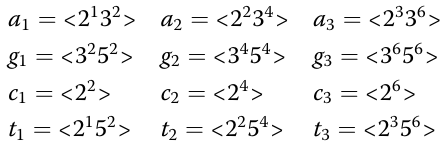
Colorizing DNA codons More interestingly, our C method can be har- 235 nessed to colorize DNA codons 17,18 for revealing the relationship between 22 amino acids and 64 genetic codons. There are 22 amino acids in a DNA codon, where each codon acid is composed of A, G, C, T 17 . For instance, acid 1 is composed of GCT, GCC, GCG, and GCA. By utilizing C , we can assign each acid a 235 color code and a number, and thus allocate all 22 amino acids on a C ring. If we denote the a , g , c , and t , the l l l l 235 color codes of A, G, C, T at position l for l = 1, 2, 3, then we have